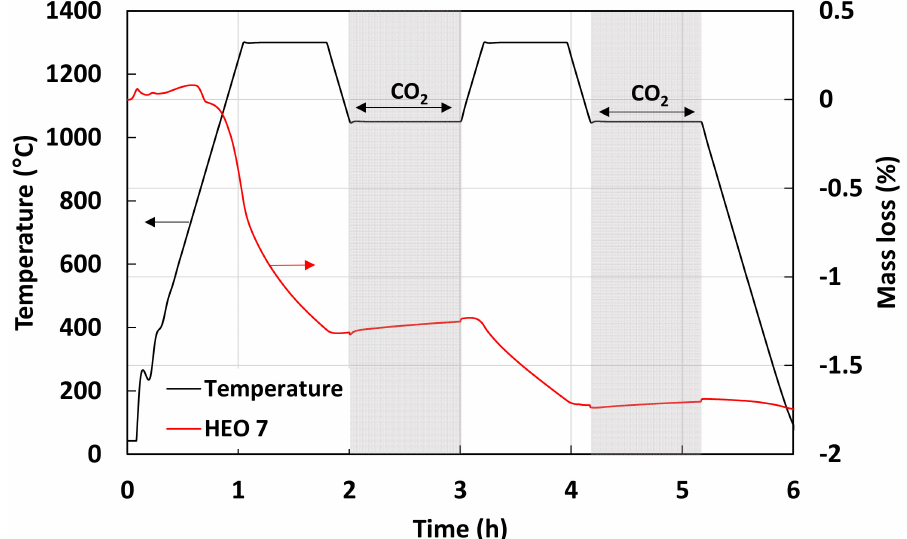
Figure 13. Thermogravimetric analysis of two consecutive CO 2 -splitting cycles with HEO 7.